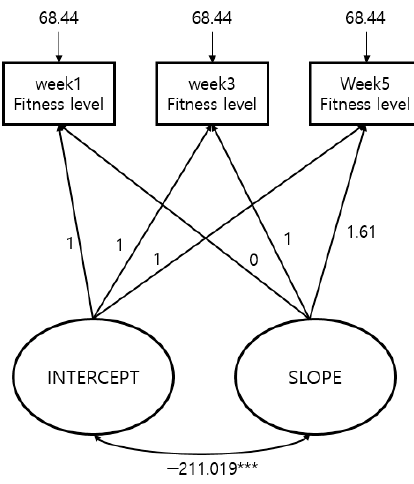
Table 5. Latent growth model analysis of changes in POMS.